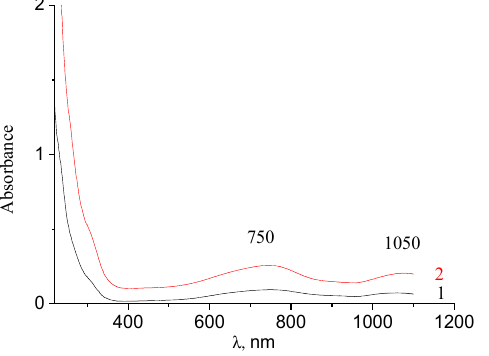
Figure 2. Electronic absorption spectra of molybdenum blue nanoparticles synthesized using various reducing agents: glucose (1) and hydroquinone (2).